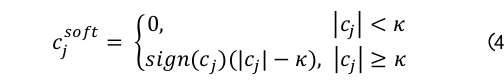
Figure 3. Exemplarily time series (black dots) approximated with a linear regression (blue line) and a piecewise linear representation (PLR) (red line). The PLR is defined by Segments A, B, and C, as well as the change points (CP) 𝐶𝑃 and 𝐶𝑃 2